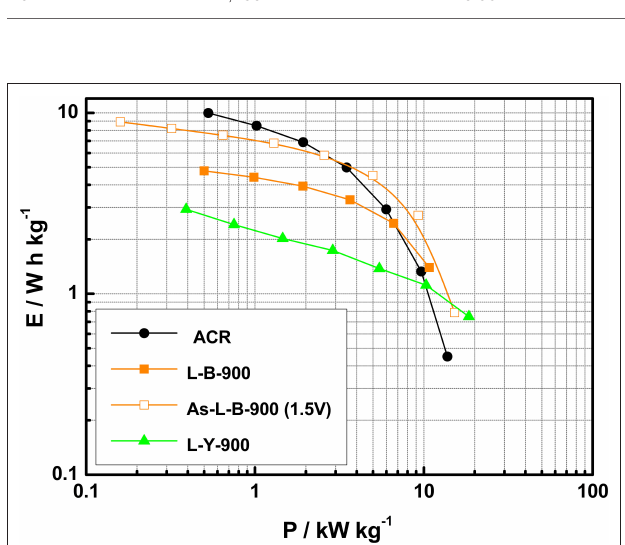
FIGURE 7 | Ragone plot for the symmetric supercapacitors (L-B-900, L-Y-900, ACR, solid dots) at a cell voltage of 1.2V and the asymmetric based on L-B-900 (hollow